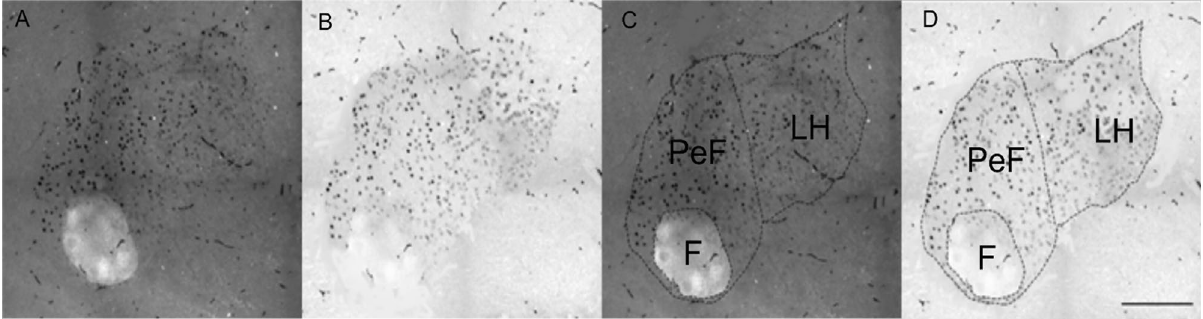
Figure 3. Photomicrographs illustrating the use of brightfield and darkfield microscopy for precise demarcation of anatomical boundaries in low background c-Fos-ir sections. ( A ) Darkfield images were utilized to reveal the detailed neuroanatomy by the contrast between myelinated tracts/areas and grey matter. ( B ) Brightfield photomicrographs of identical sections revealed c-Fos-ir nuclei; ( C ) the darkfield photomicrographs were used to precisely outline regions of interest (ROI). ( D ) The ROI was transferred to the brightfield micrograph for automated cell counting. F fornix, PeF peri-fornix, LH lateral hypothalamus.